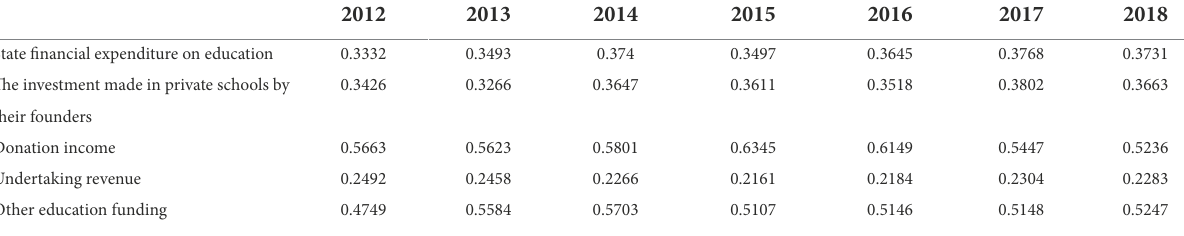
TABLE 4 Gini coefficients for different sources of interprovincial education funding.